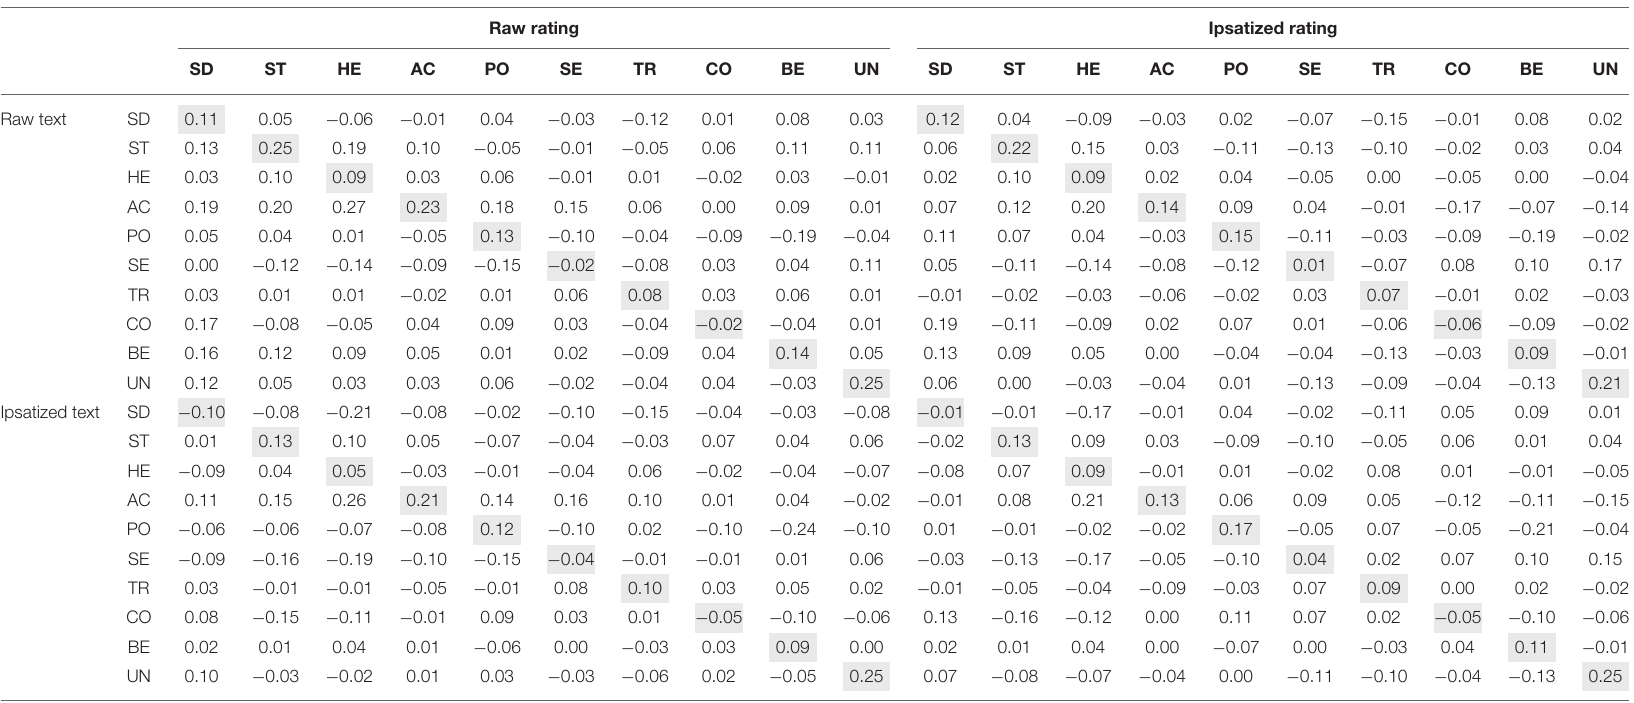
TABLE 7 | Overall correlation matrix comparing values across data modalities in Study 2.